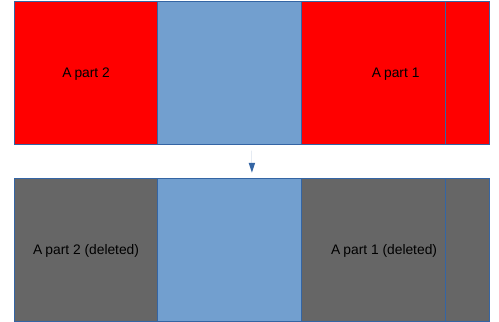
Figure 9. Test Case 8. Fragmented file A, which starts at the end of the file system and wraps around to the beginning, is